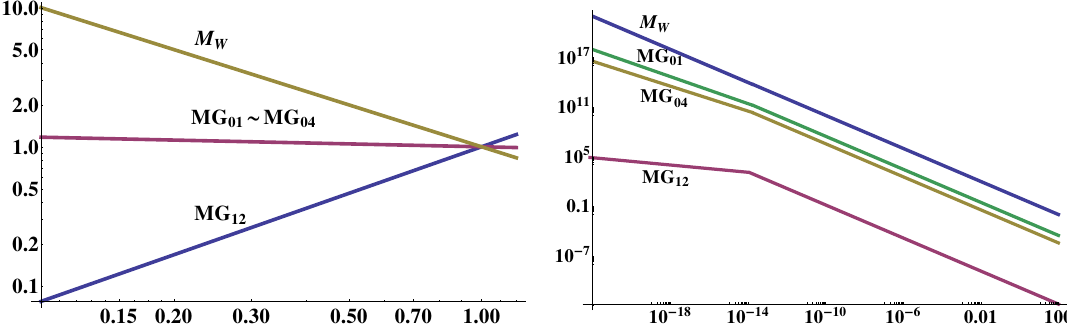
Figure 11 . The mass gaps MG (in units of (cid:3) QCD ) as functions of (cid:3) QCD L for two admissible theo- ries with N c = 5. For comparison, we also plot the mass the W-boson. On the left: n G = 2 ; N F = 3. Weak coupling is lost at L(cid:21) QCD ’ 1. On the right: n G = 3 ; N F = 8. See the text for